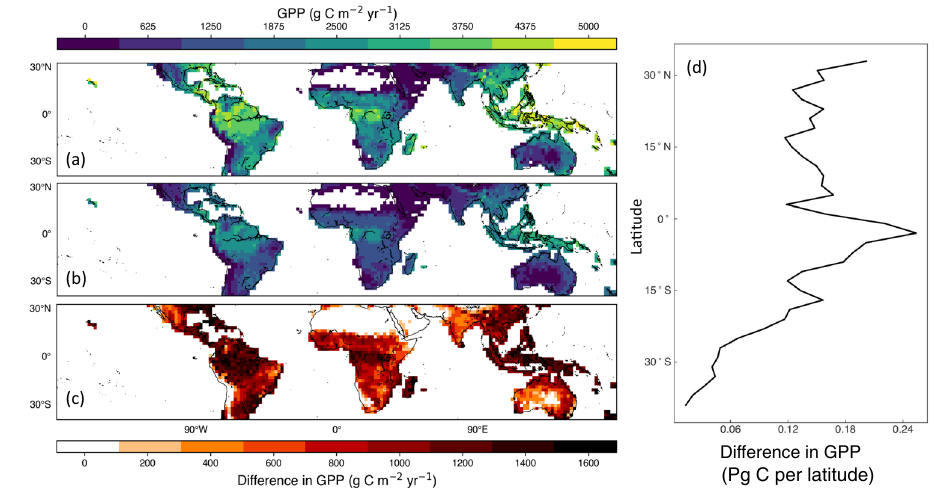
Fig.4|Modelledgrossprimaryproductivity(GPP)fortropicalandsubtropical zones with ORCHIDEE-CNP. a GPP from ORCHIDEE-CNP simulations assuming N constraintsbutahighPeverywhere(noPconstraint). b GPPasin a ,butincludingP constraintsaccording toaversionof the multipleregression inTable2.The colour